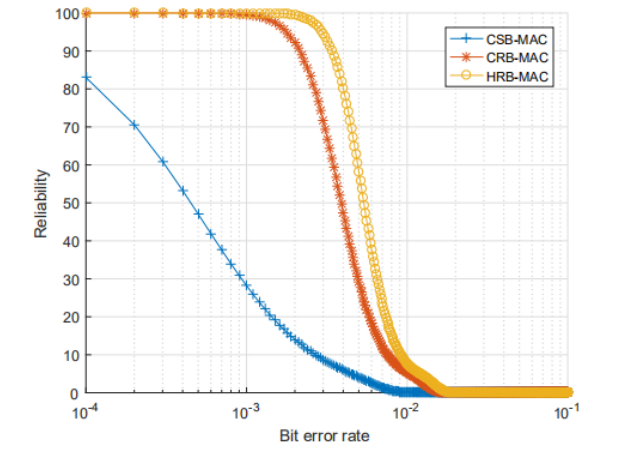
Figure 4. Reliability performance against BER, in terms of PDR